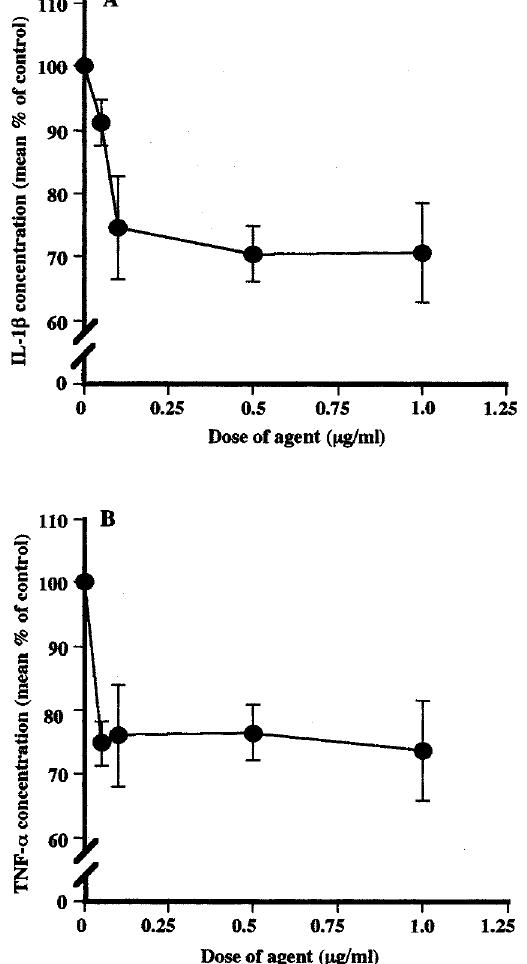
FIG. 1. Influence of RXM on pro-inflammatory cytokine production from human PBM in response to LPS stimulation in vitro . The cells (2 3 10 6 /ml) were cultured in the presence of various concentrations of RXM. The culture supernatants stimulated with 1.0 m g/ml LPS were harvested 24h later. IL- 1 b (A) and TNF- a (B) concentrations were assayed by ELISA. Each data is the mean percent of control (without agent)±SD of six different subjects.